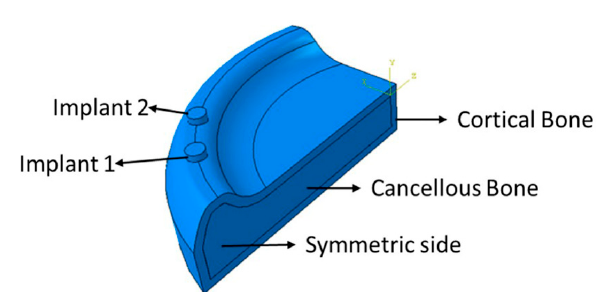
Figure 1. One half of the maxilla (three-implants model).